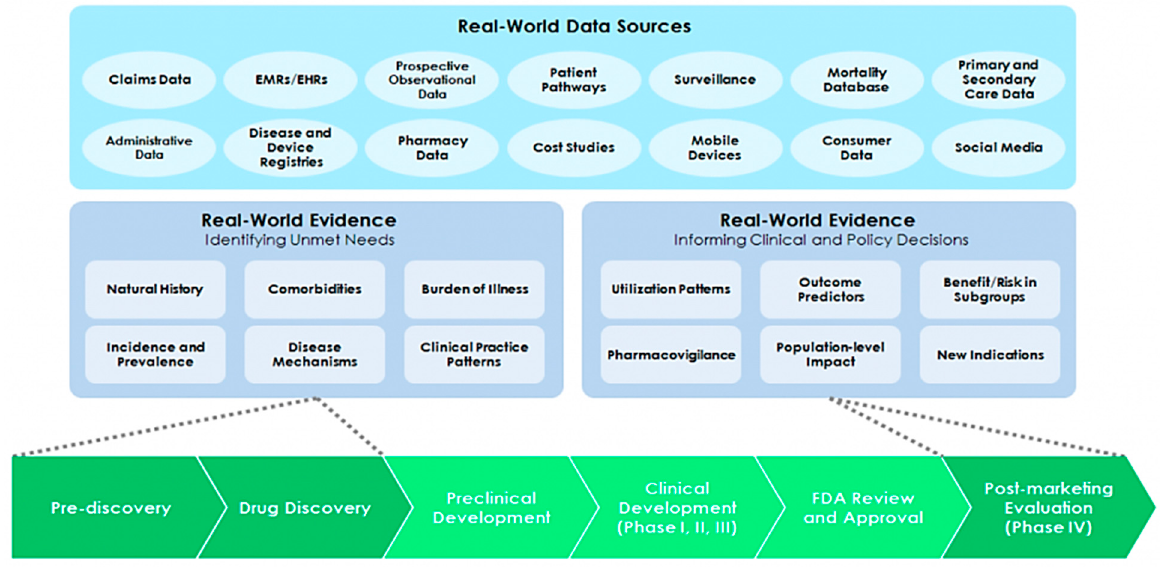
Figure 1. Summary of diverse real-world data sources and evidence used to inform drug discovery and clinical and policy decision-making (Reprinted/adapted with permission from Galson and Simon, 2016. National Academies Press) [3].